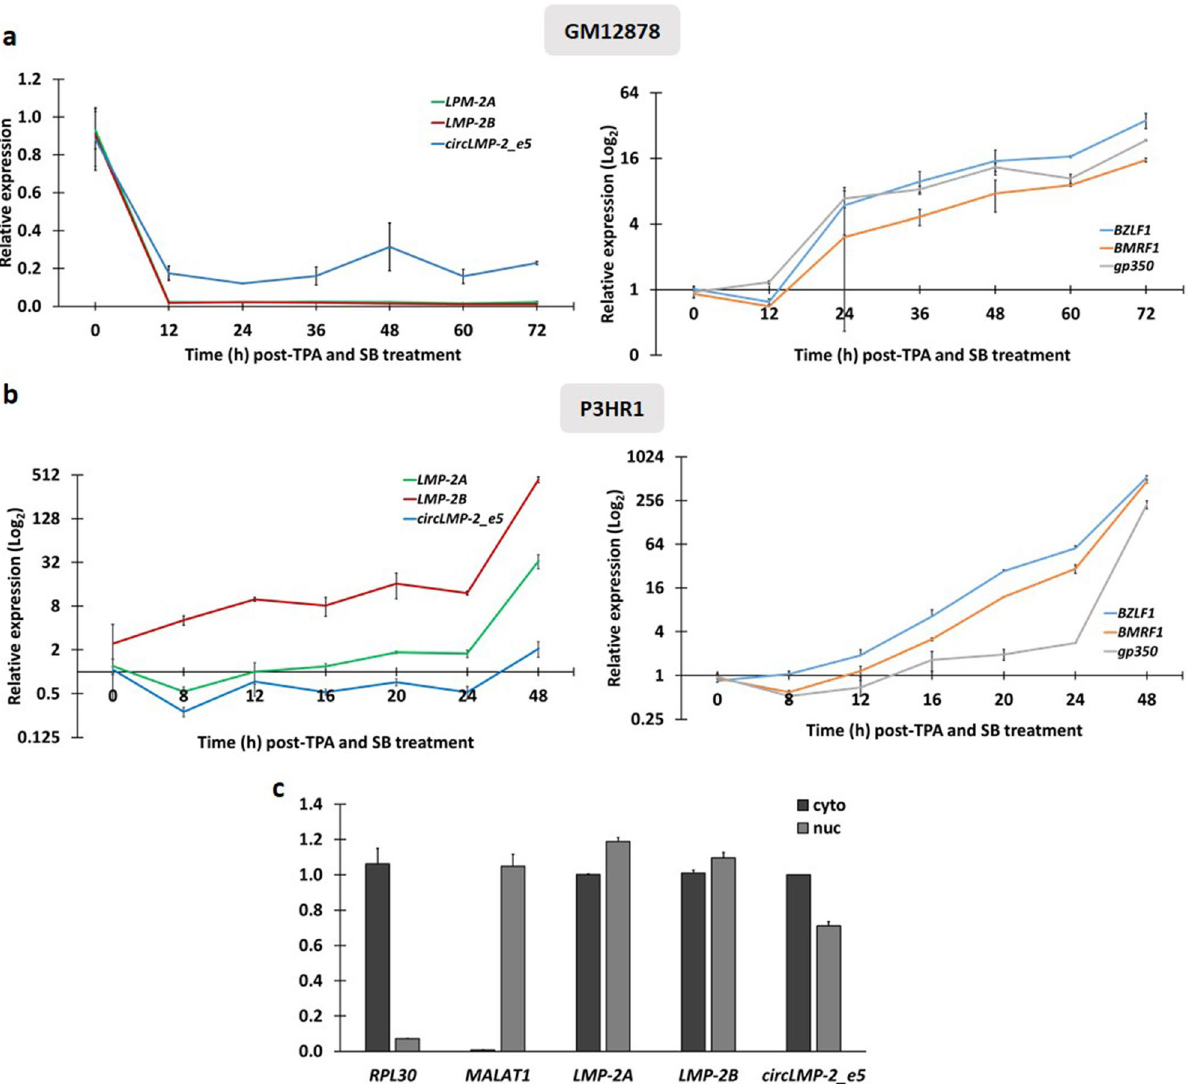
Figure 3. Temporal and spatial expression of linear LMP-2 and circ LMP-2_e5 . ( a , b ) Kinetic expression of EBV linear LMP-2 and circ LMP-2 _e5, as well as EBV lytic genes in ( a ) GM12878 and ( b ) P3HR1 cells were carried out for the indicated time period using RT-qPCR. Data was normalized to RPL32 / UBC and represents the mean ± SD of two independent experiments. ( c ) RT-qPCR analysis using junction-specific divergent primers showed LMP-2 and circ LMP-2 _e5 were located in both nucleus and cytoplasm of GM12878 cells. Data was normalized to the RNA yield ratio and represents the mean ± SD of two independent suggest that B cells express more circ LMP-2_e5 as compared to NPC cells. Moreover, the expression of cir- c LMP-2_e5 correlates positively with linear LMP-2 expression upon lytic reactivation as shown in Fig. 2b and c. In addition to the existing EBV-positive cell lines, we also examined the expression of circ LMP-2_e5 in newly developed LCLs generated by infecting healthy donor B cells with EBVs derived from infectious mononucleosis patient (B95.8) and NPC cases (M81, G517, B110 and G514). As expected, all newly generated LCLs expressed both LMP-2A and circ LMP-2_e5 (Fig. 2d,e) . Interestingly, LCLs generated by NPC-derived EBV generally had higher expression of circ LMP-2_e5 as compared to LCLs generated by B95.8. LCL_G514 harbored the highest expression of circ LMP-2_e5 whereas LCL_B95.8 had the lowest expression of circ LMP-2_e5 . Together, this result suggests that circ LMP-2_ e5 expression is not unique to the existing EBV-positive cell lines but also in all newly generated LCLs. To further investigate the expression dynamics of circ LMP-2 _e5 in a more detail manner, a time-course analysis of the expression of EBV lytic genes, linear LMP-2 and circ LMP-2 _e5 was carried out in GM12878 and P3HR1 cells (Fig. 3a and d). GM12878 and P3HR1 cells were chosen as these two cell lines are B cells which express higher amount of circ LMP-2_e5 and show different circ LMP-2_e5 expression patterns upon lytic reac- tivation, whereby circ LMP-2_e5 expression is reduced in GM12878 cells, but increases in P3HR1 cells (Fig. 2a). In GM12878 cells, upon entering the lytic state after 12 h of TPA and SB treatment (Fig. 3a, right panel), both